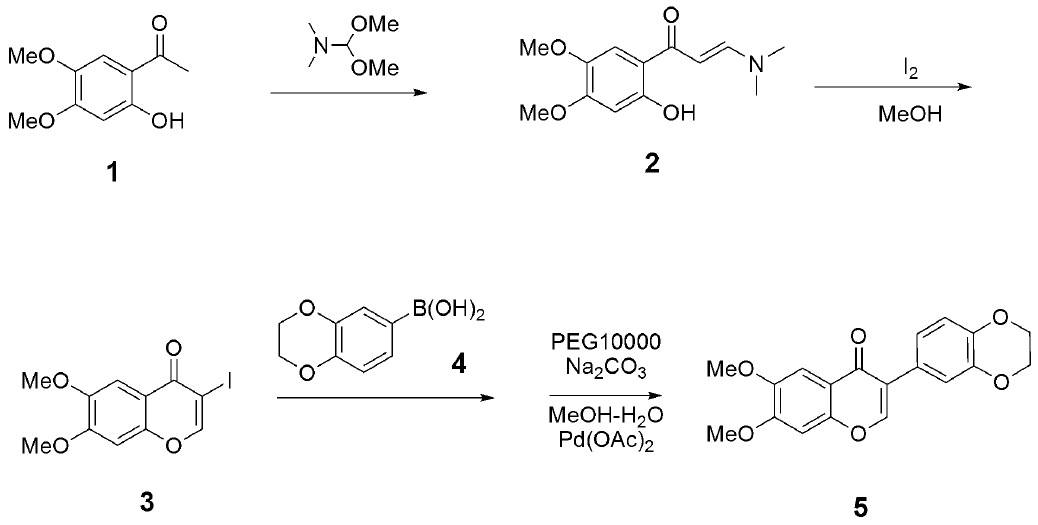
Scheme 1. Synthetic procedures for the title compound 5